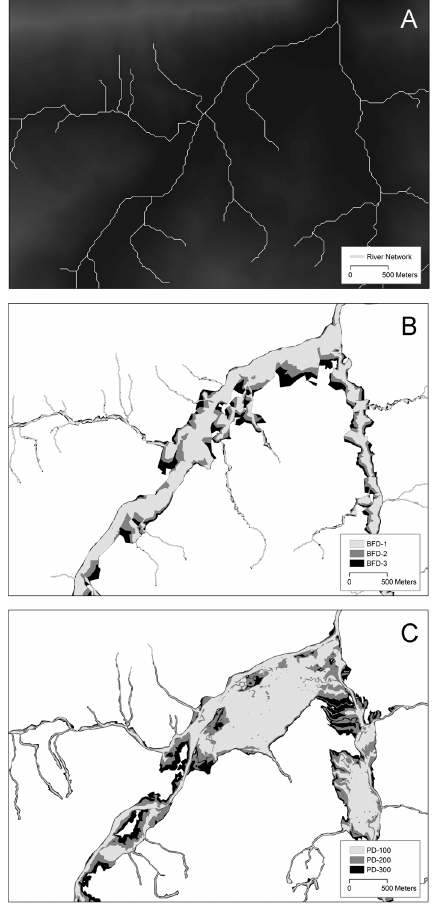
Fig. 4. Illustration of river centre-lines over the digital elevation model at a confluence ( A ) and bankfull depth floodplain surfaces ( B ; at 1, 2 and 3 bankfull depth heights) and path distance flood- plain surfaces ( C ; at 100, 200 and 300 threshold values) at the same